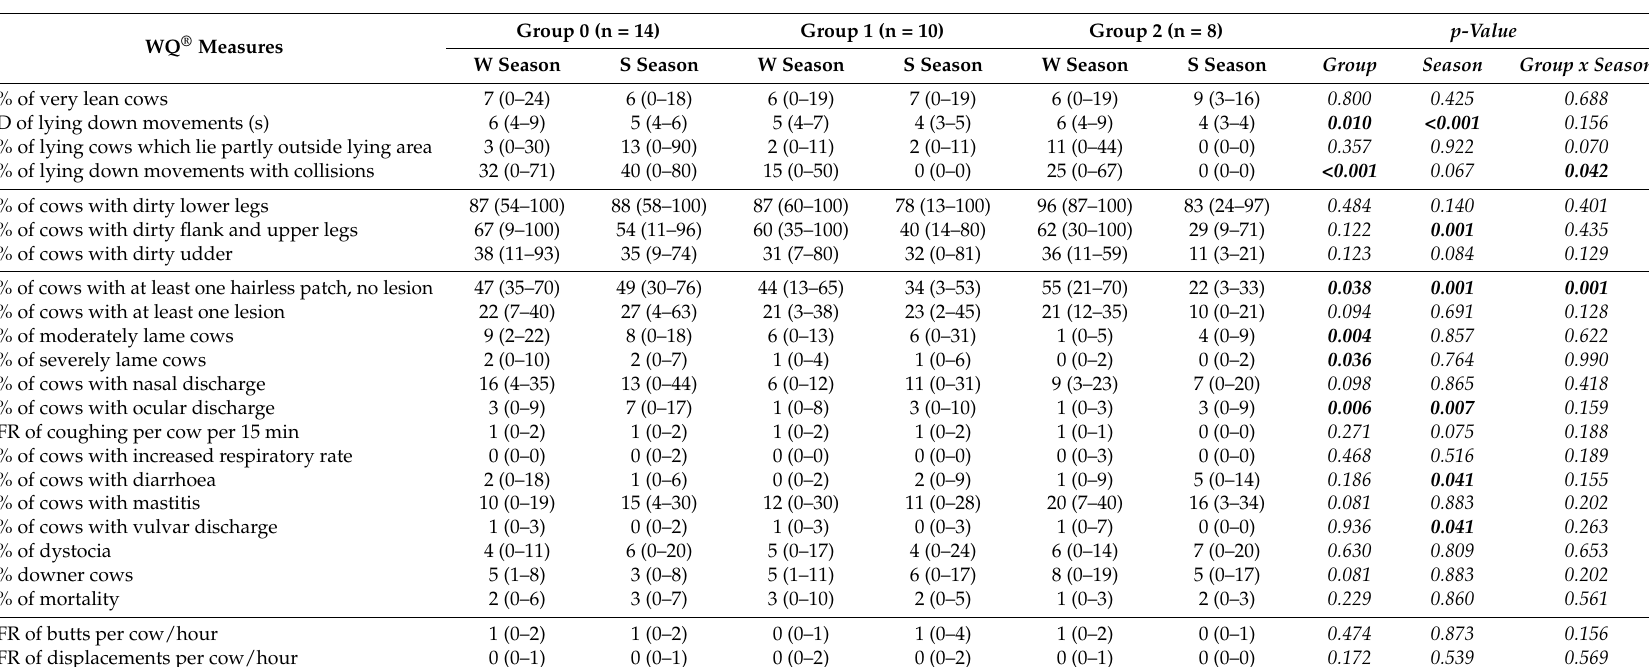
Table 2. Animal-based WQ ® measures (mean (min-max)) for three groups (Groups 0, 1, and 2) and two seasons (W = winter and S = summer). Bold highlighted p -values are p < 0.05. Units are given in the description